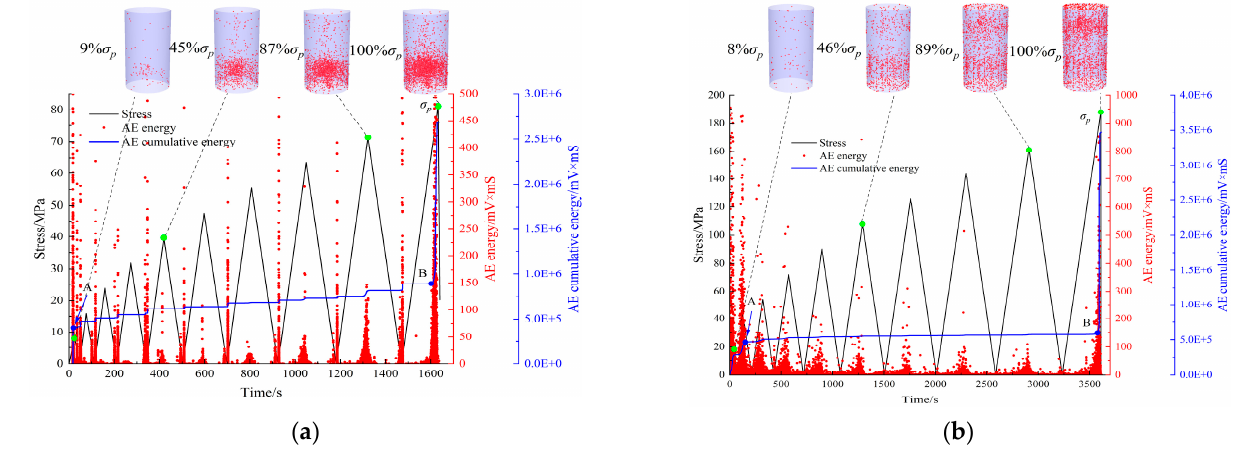
Figure 10. The AE energy and location evolution under CLLCL. ( a ) Sandstone; ( b )